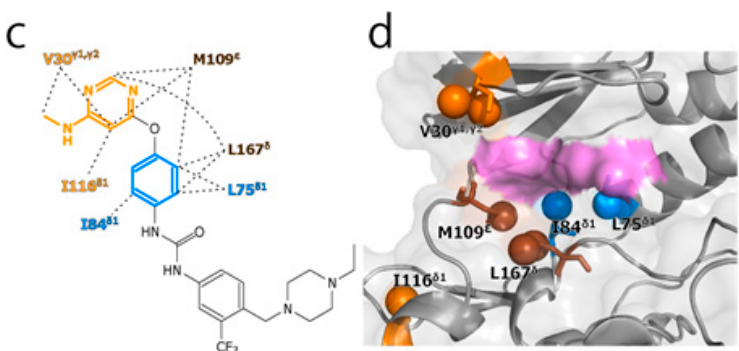
Figure 2. Structural characterization of the interaction between AST-487 and p38 α . ( a ) The 1 H– 13 C band-selective optimized-flip-angle short-transient–heteronuclear multiple quantum coherence (SOFAST–HMQC) spectra (Ile- δ 1 region) of p38 α with 1 H/ 13 C isotope labeling at the methyl positions of isoleucine ( δ 1), leucine, valine, and methionine in a uniformly deuterated background ([ILVM–methyl– 1 H/ 13 C, U- 2 H] p38 α ) in the presence (red) and absence (black) of an equimolar concentration of AST-487; ( b ) The structural mapping of the chemical shift perturbations (CSPs) induced by the addition of AST-487. Methyl groups with CSPs larger than the linewidth are shown as red spheres in the structure of p38 α in the apo state (Protein Data Bank (PDB) code: 1P38) [39]. The ATP-binding site is indicated by the blue broken line; ( c ) The intermolecular nuclear Overhauser effects (NOEs) observed between AST-487 and p38 α are illustrated by broken lines. For Leu-167, only one resonance of the two δ -methyl groups was identified with no stereospecific assignments; thus, it is labeled as “ δ ”. The pyrimidine ring and the methylamino substituent are colored orange, while the ether-linked phenyl ring is colored blue; ( d ) The methyl sites with intermolecular NOEs with AST-487 are shown as spheres in the p38 α structure (PDB code: 1A9U) [40]: orange methyl sites represent NOEs with the pyrimidine ring or its methylamino substituent; blue methyl sites represent NOEs with the ether-linked phenyl ring; and brown methyl sites represent NOEs to both. The surface of a representative p38 α inhibitor, SB203580, is colored purple to indicate the typical compound-binding site.